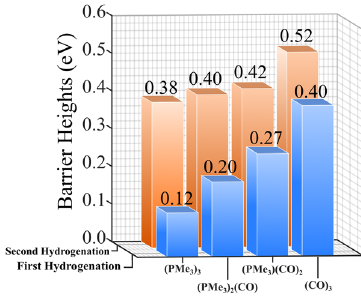
Fig. 5 Ligand-induced barrier heights of CO 2 → HCOOH conversion. The relative trend of the barrier heights for both the hydrogenation steps